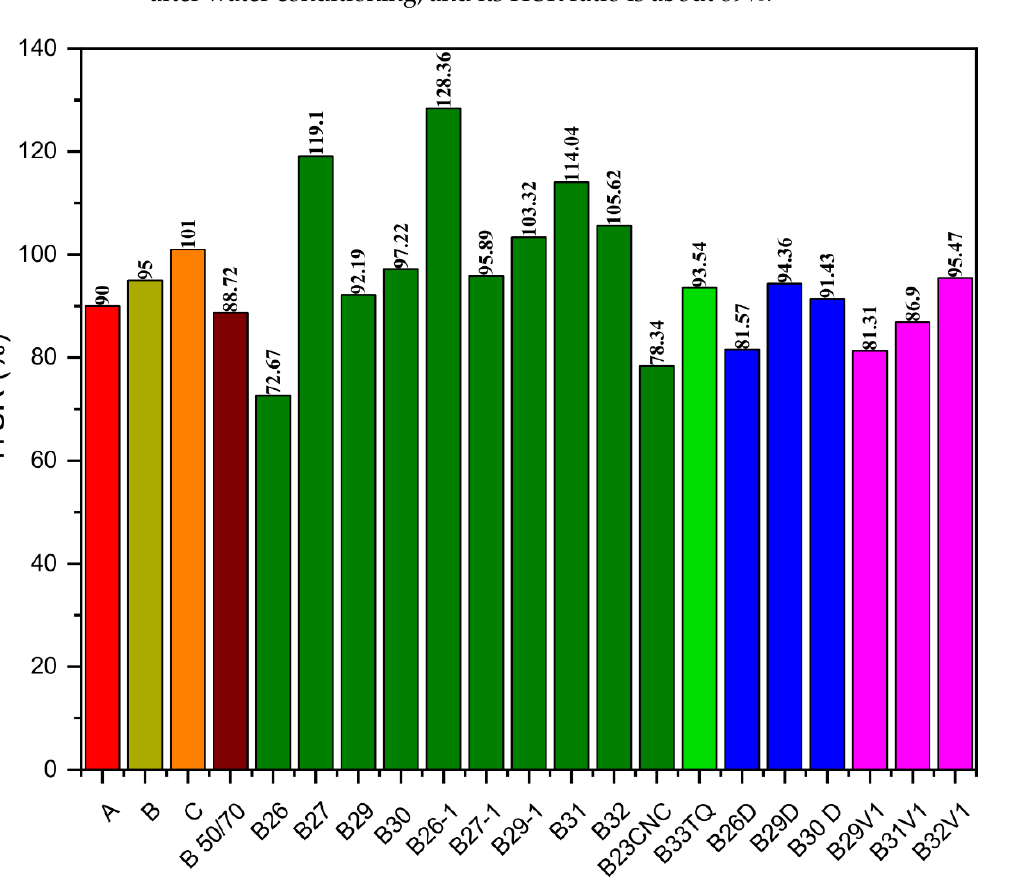
Figure 7. Results of the ITSR values at 20 °C of the recycled asphalt mixtures produced with 100% RAP and the alternative binders. Legend: